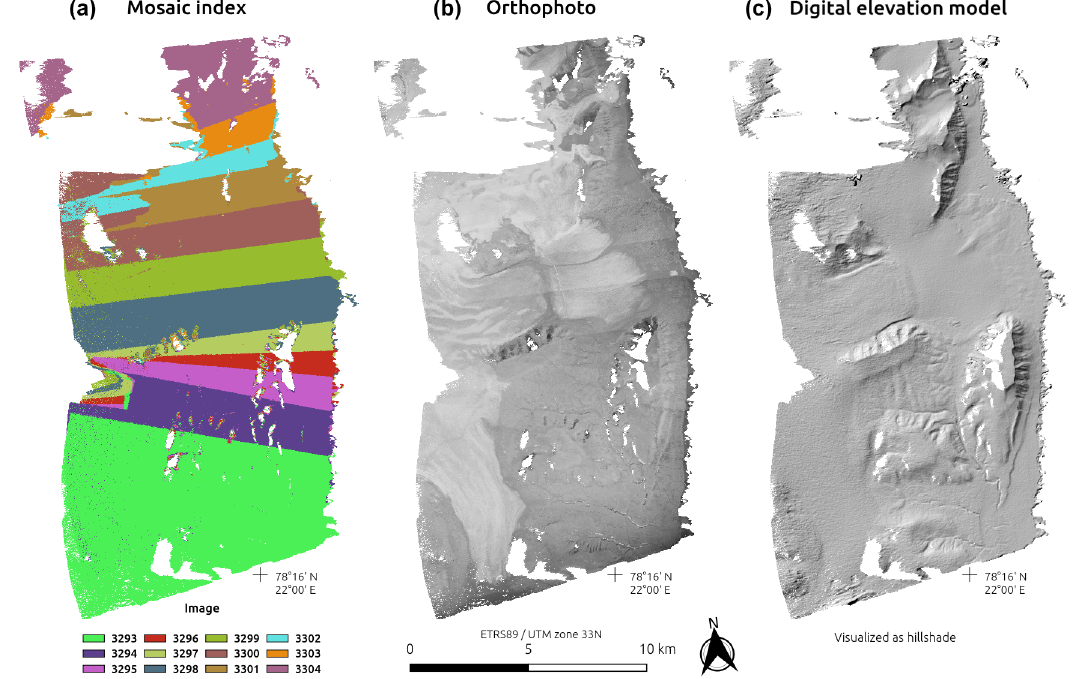
Figure 7. Raster mosaic. (a) Map of the mosaic, with each color representing an individual source-point raster. (b) Mosaiked orthoimage. (c) Mosaicked hillshade